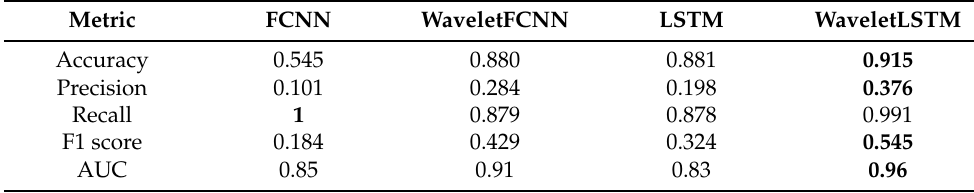
Figure 9. Confusion matrix of different models. Table 3. Comparison results of different models in terms of classification